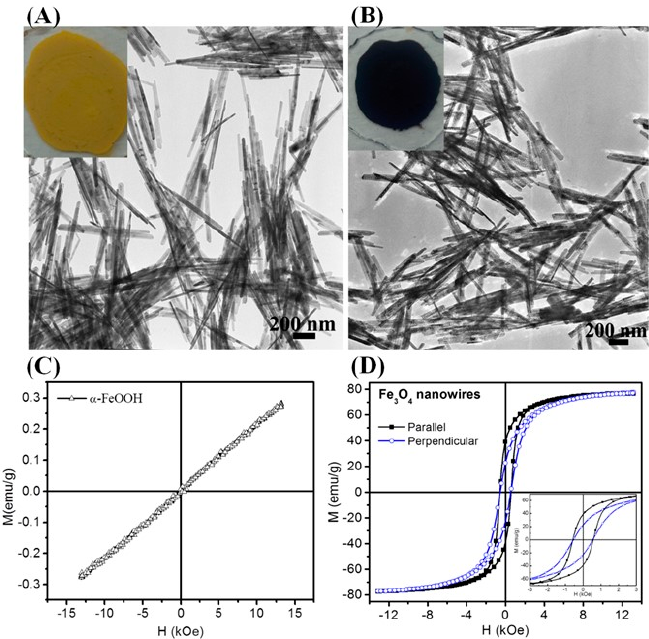
Materials 2017 , 10 , x FOR PEER REVIEW 17 of 31 disordered spins in blue are dominant at the corners of the cube, while they are broadly distributed at the surface of the sphere. The shape effect has also been noticed in Fe 3 O 4 nanostructures of different Figure 11. ( A ) TEM image of α -FeOOH NWs synthesized by hydrolysis of FeCl 3 at 160 ◦ C. Inset Figure 11. ( A ) TEM image of α -FeOOH NWs synthesized by hydrolysis of FeCl 3 at 160 °C. Inset shows shapes. The change in magnetization value with respect to shape and size of these nanostructures is shows the α -FeOOH NWs powder produced by a single experiment. ( B ) TEM image of Fe 3 O 4 NWs the α -FeOOH NWs powder produced by a single experiment. ( B ) TEM image of Fe 3 O 4 NWs synthesized by annealing α -FeOOH NWs at 300 °C. Inset shows the color of Fe 3 O 4 NW powder synthesized by annealing α -FeOOH NWs at 300 ◦ C. Inset shows the color of Fe 3 O 4 NW powder enhanced M S values. The enhanced M S values are assumed to be due to anisotropic shape which obtained after annealing α -FeOOH NWs. Room temperature hysteresis loops of ( C ) α -FeOOH NWs lowers the surface spin disordered effect as explained in Zn 0.4 Fe 2.6 O 4 nanocubes case [2,68]. The M S obtained after annealing α -FeOOH NWs. Room temperature hysteresis loops of ( C ) α -FeOOH NWs and ( D ) Fe 3 O 4 NWs. The insert of D shows the low-field magnetization loops [111]. value of the rods is 50–65 emu/g. The low M S value is attributed to the surface spin canting or surface and ( D ) Fe 3 O 4 NWs. The insert of D shows the low-field magnetization loops [111]. organic defective layer of the nanorods. The effect of shape anisotropy on ordering of surface atomic spins has also been well demonstrated by Cheon et. al [2] . Among a cube and a sphere with the same material volume and number of cations of Zn 0.4 Fe 2.6 O 4 nanoparticles, the cube has greater M S (165 emu/g (Fe+Zn) ) compared to that of the sphere (145 emu/g (Fe+Zn) ) (Figure 12D). The cube has lower energy surface facets of family (100); in contrast, the surface of a spherical nanoparticle is constructed of different facets, which results in a larger surface spin disorder, hence higher surface anisotropy. A simulated result shows that the density of the disordered spins is higher in the sphere than in the cube (Figure 12E and 12F). The images are color-mapped according to the angle of the spin deviation versus the external magnetic field, red indicates ordered spins and blue indicates highly disordered spins. The